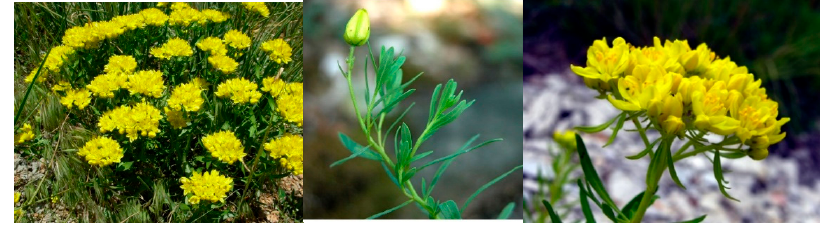
Figure 1. The photographs of Haplophyllum suaveolens Ledeb.